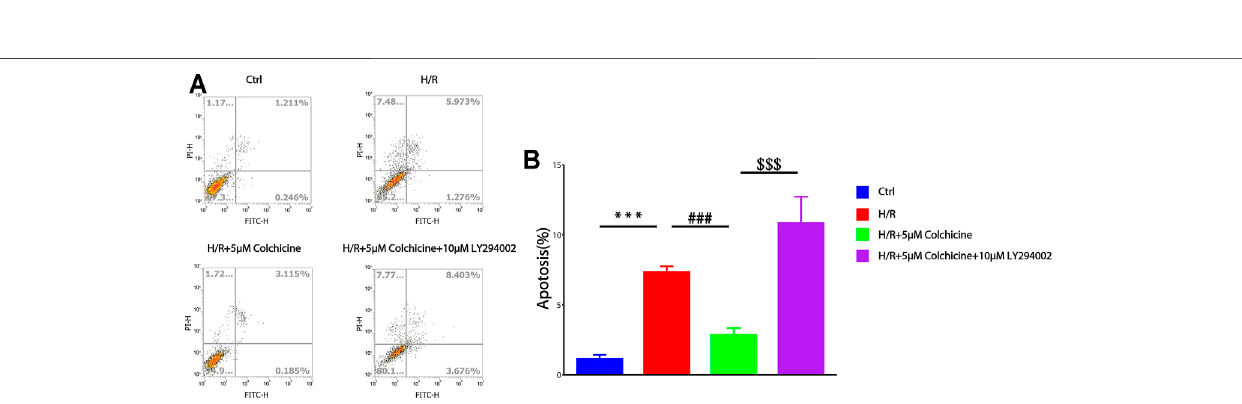
FIGURE 9 | Flow cytometry was used to detect the apoptosis-inducing effect of colchicine on H9C2 cells. (A) the apoptotic effects of colchicine was measured through fl ow cytometry. (B) The quantitative results were analyzed. The data were expressed as mean ± SD (*** p < 0.001 compared with control; ### p < 0.001 compared with H/R group; $$$ p < 0.001 compared with colchicine treated alone).